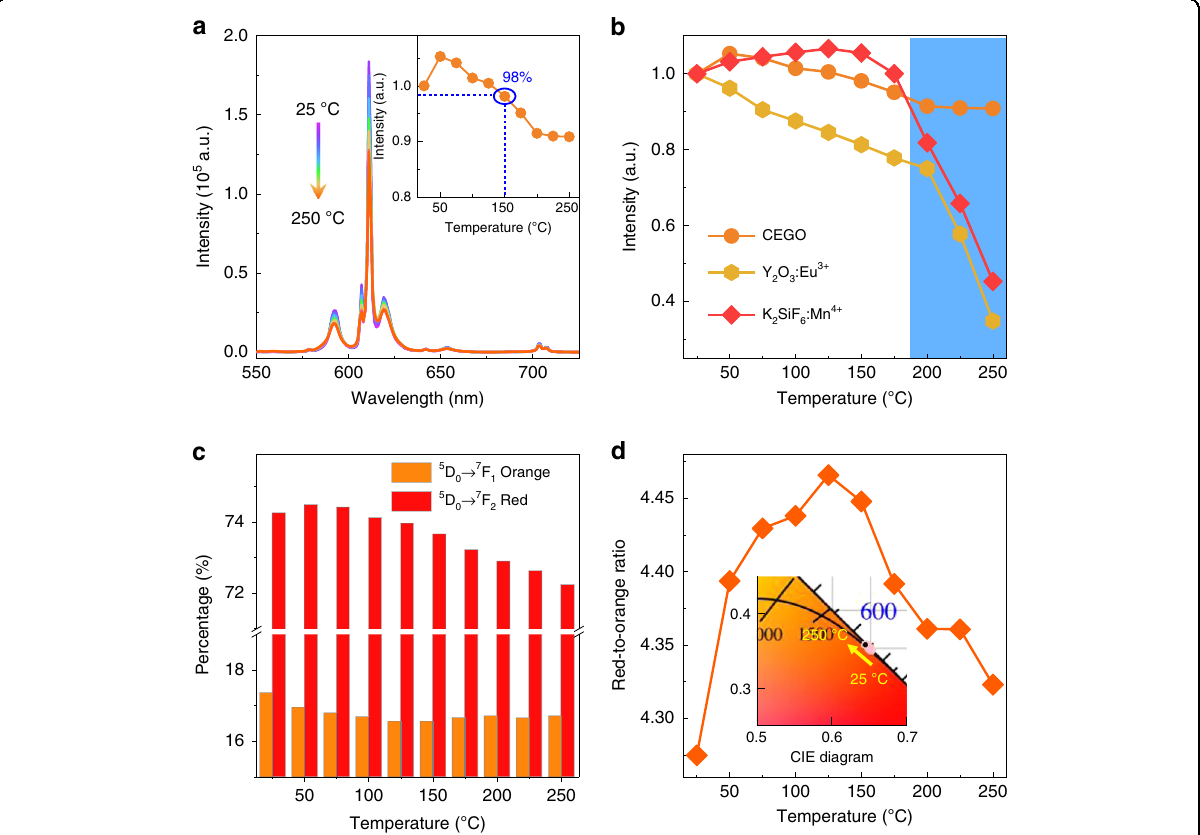
Fig. 4 Temperature-dependent photoluminescence properties of CEGO. a Temperature-dependent PL spectra of CEGO from 25 to 250 °C. The PL intensity of CEGO is depicted in the inset. b Temperature-dependent PL intensity of CEGO compared with the commercial red Y 2 O 3 :Eu 3 + and K 2 SiF 6 :Mn 4 + phosphors. c The variation trend of the 5 D 0 – 7 F 2 (red) and 5 D 0 – 7 F 1 (orange) transitions in temperature-dependent PL spectra for CEGO from 25 to 250 °C. d The variation in the R / O ratio for CEGO from 25 to 250 °C. The CIE chromaticity coordinate diagram of CEGO at different temperatures (25 – 250 °C) is shown in the